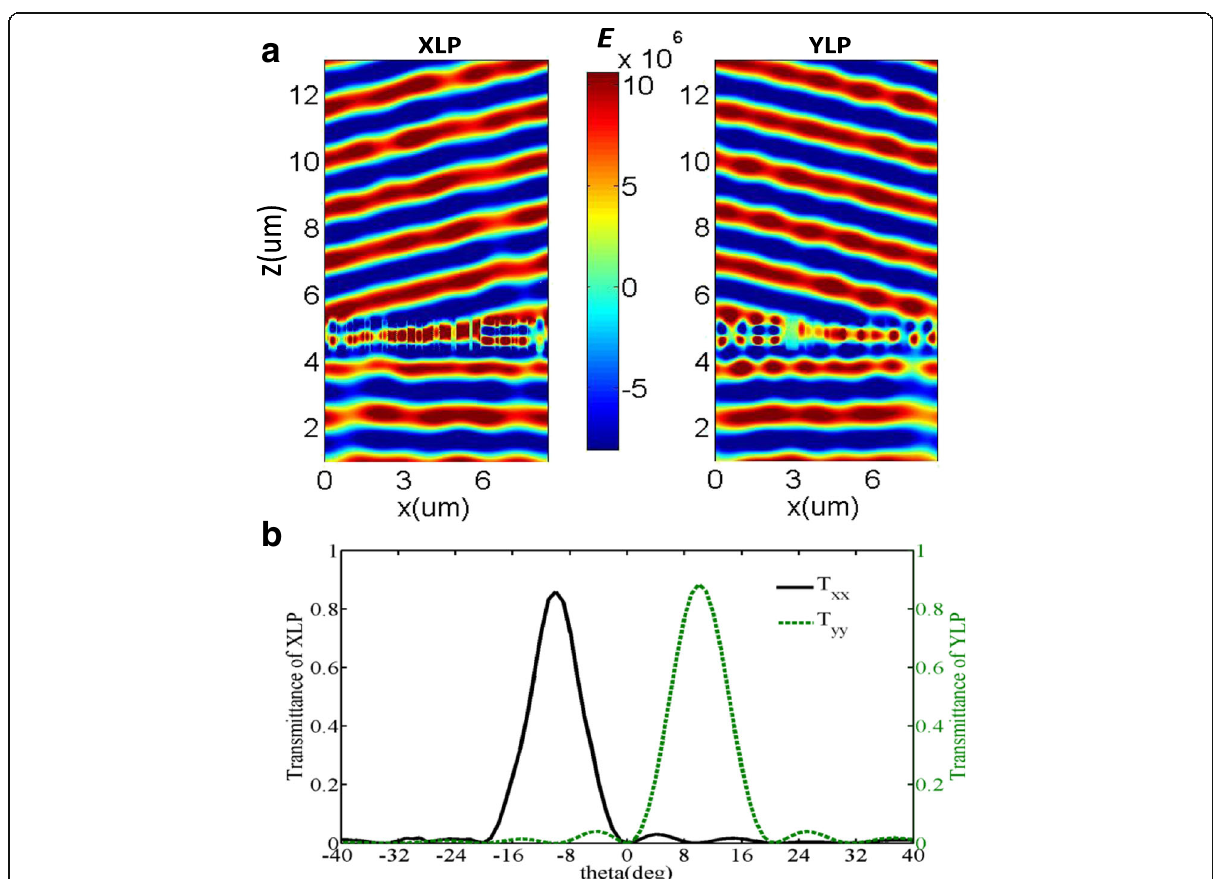
Fig. 3 a The electric field distributions ( E ) of extracted transmitted XLP ( left ) and YLP ( right ) light, when a normal incident light with 45 ° linear- polarization at the wavelength of 1500 nm transmitted through the designed metasurfaces. b The co-polarized transmitted efficiencies of the designed metasurfaces as the function of the transmitted angle under the illuminations of an X-polarized and Y-polarized lights,